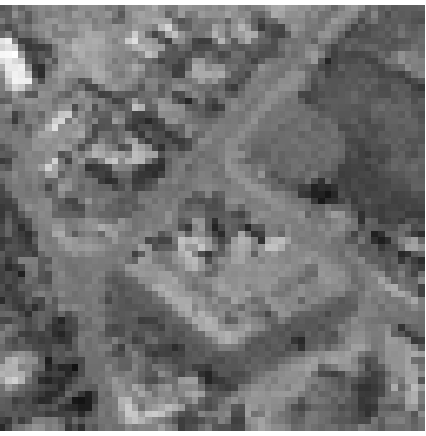
Figure 5. Low resolution with White Gaussian noise input.